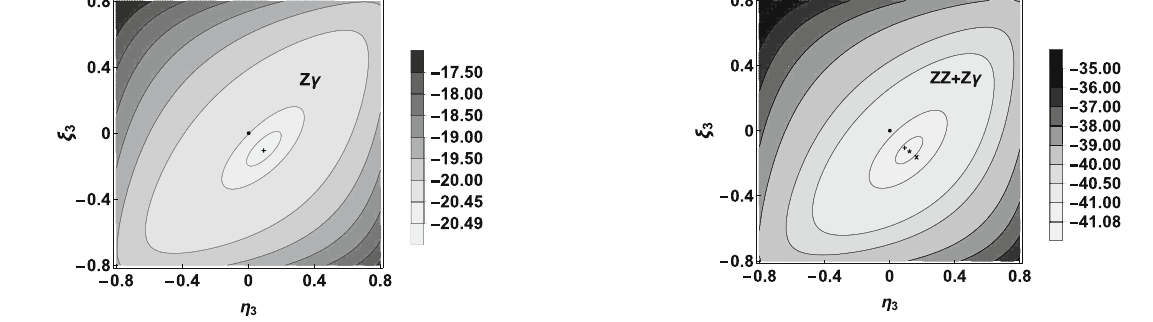
√ s = 500 GeV and L = 100 fb − 1 for different η 3 and ξ 3 from MCMC